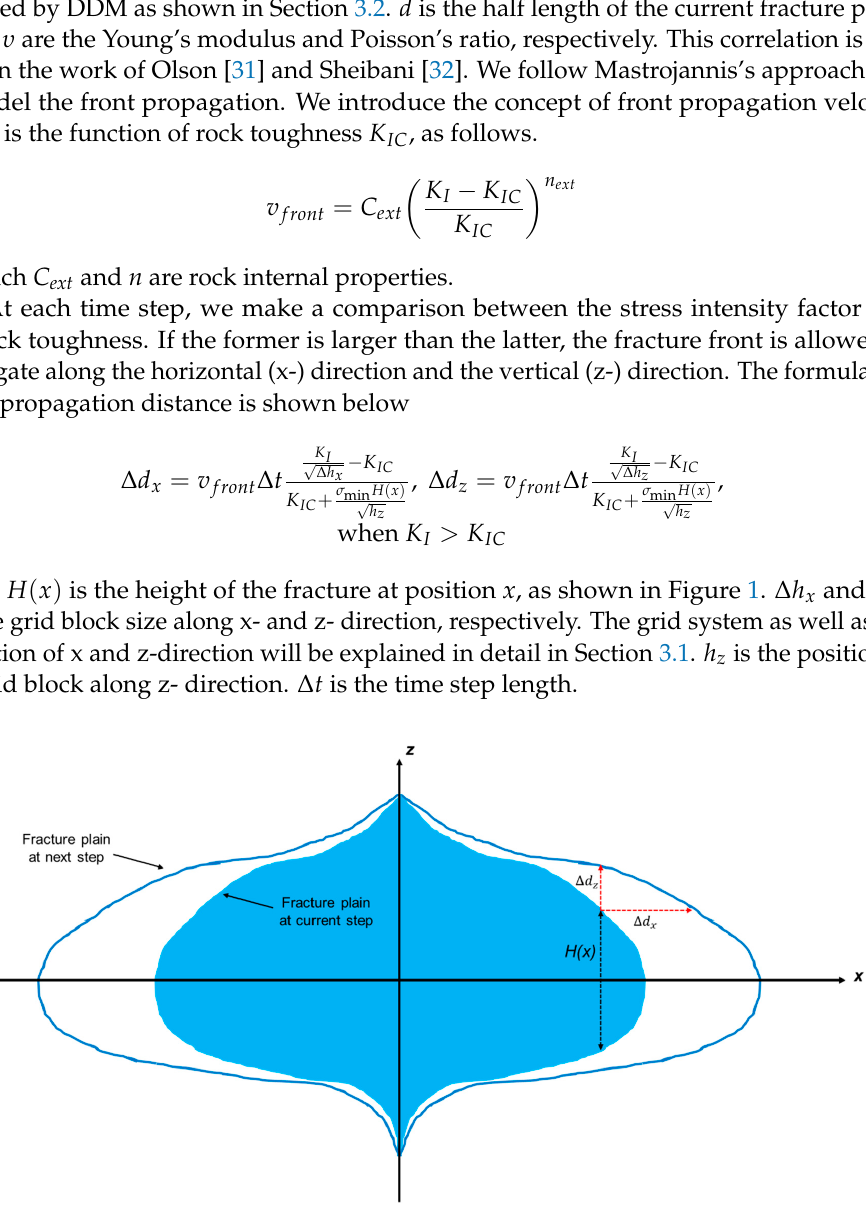
Figure 1. Conceptual model of a propagating fracture plane. The fracture is allowed to propagate along x-direction and z-direction and to deviate along y-direction which is perpendicular to the fracture plane.